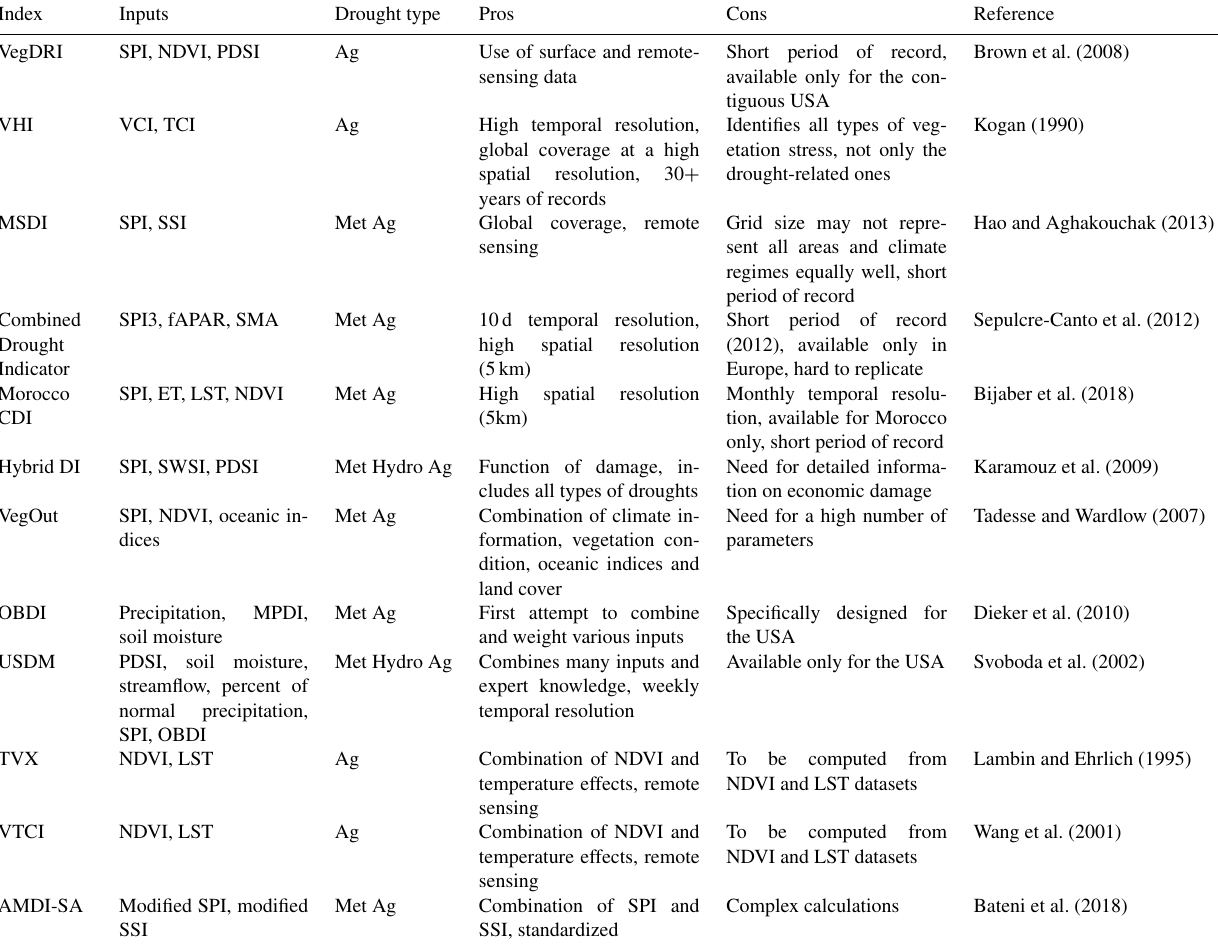
Table 2. An overview of aggregate and composite drought indices useful for agricultural drought monitoring; Met is meteorological, Hydro is hydrological, Ag is agricultural. Input abbreviations not defined in the text are as follows: fraction of absorbed photosynthetically active radiation (fAPAR), soil moisture anomaly (SMA), evapotranspiration (ET) and land surface temperature